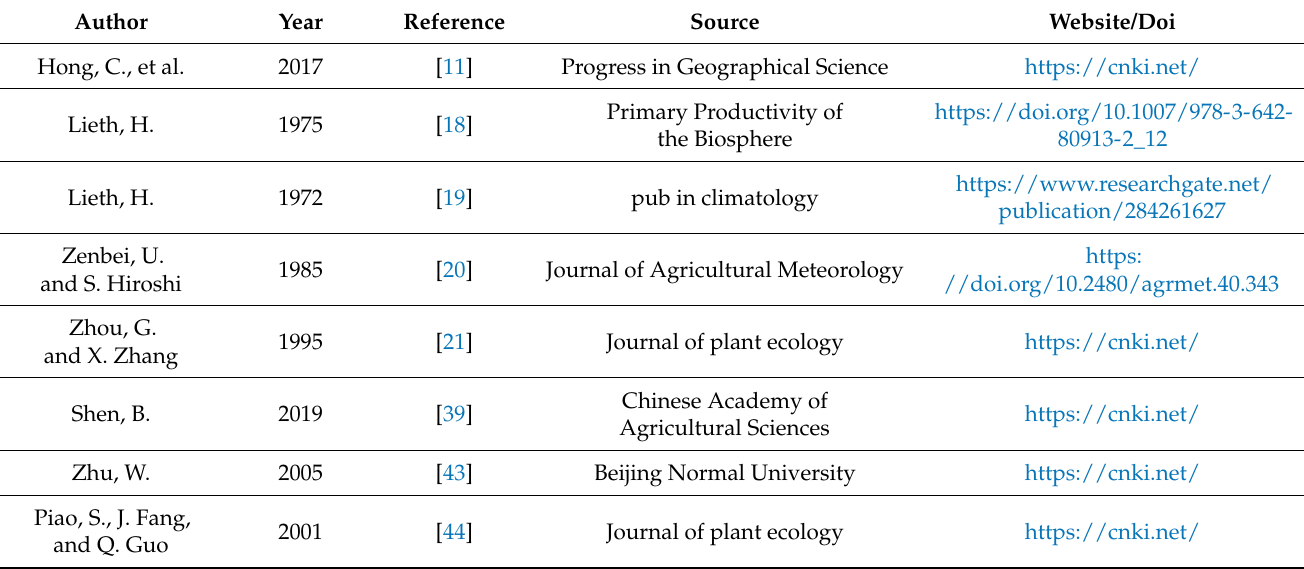
Table A1. Data related references cited in this